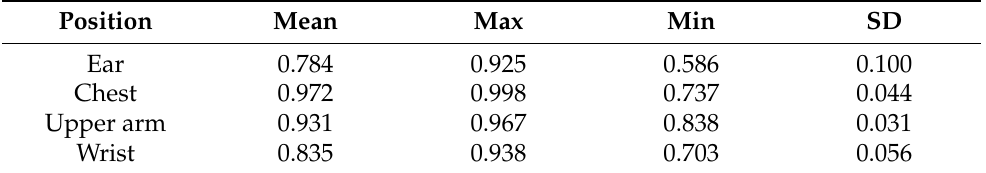
Table 8. Maximum and minimum Classification accuracy of 50 random template exercise segments